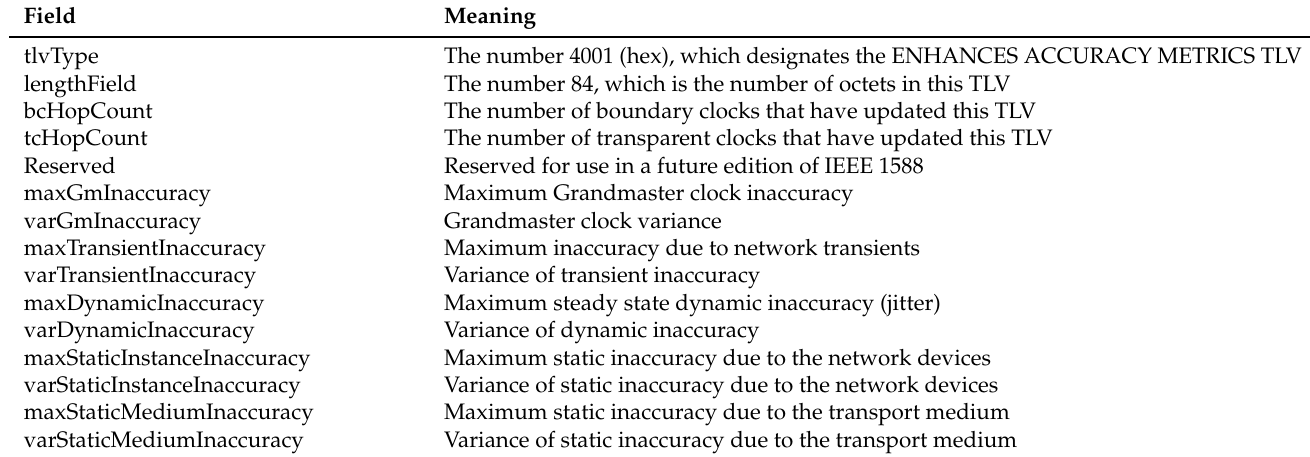
Table 1. Structure of the ENHANCED_ACCURACY_METRICS TLV defined in IEEE 1588-2019 to deliver accumulated timing inaccuracy information to PTP-capable devices on the